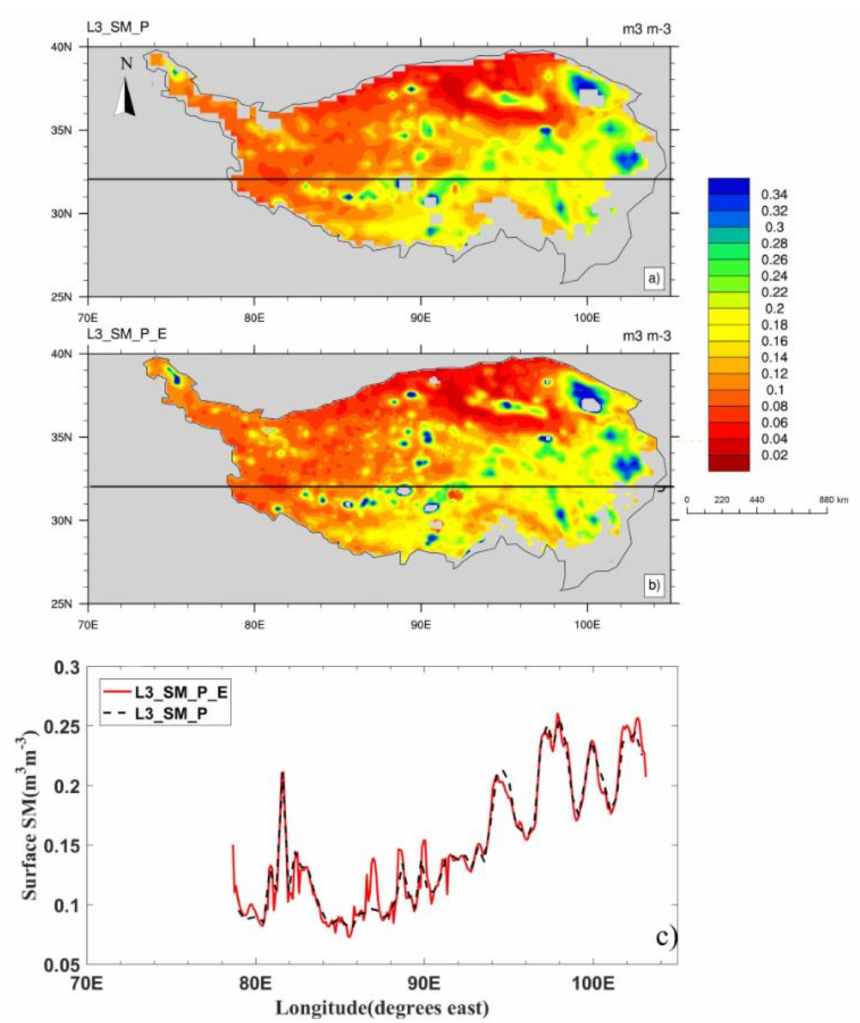
Figure 3. Maps of summer-mean (June–August) soil moisture in 2015 (unit: m 3 m − 3 ) based on: ( a ) L3_SM_P; and ( b ) L3_SM_P_E; and ( c ) longitudinal distributions of soil moisture based on L3_SM_P (red solid line) and L3_SM_P_E (black dashed line) along the transect, marked by black horizontal lines in ( a , b